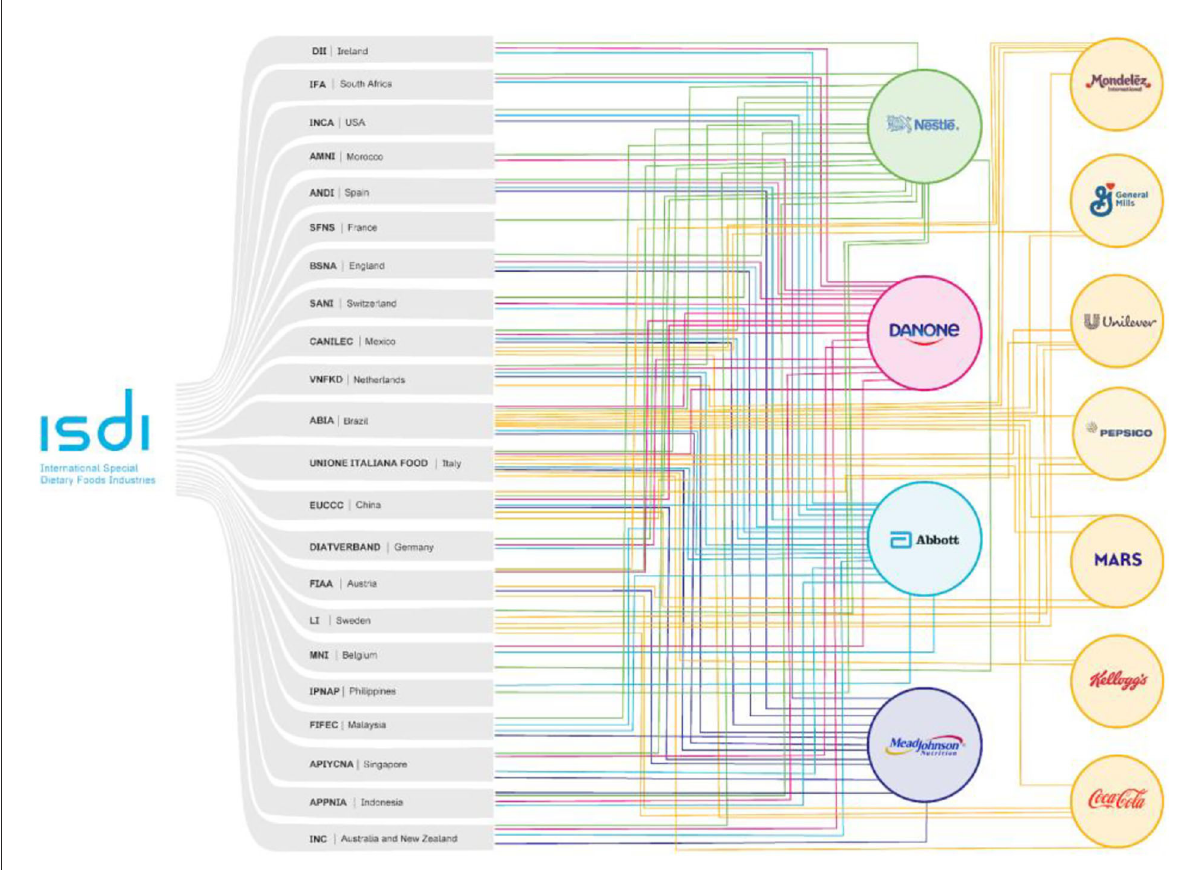
FIGURE4 Commercial associations members of International Special Dietary Foods Industries and links with Big